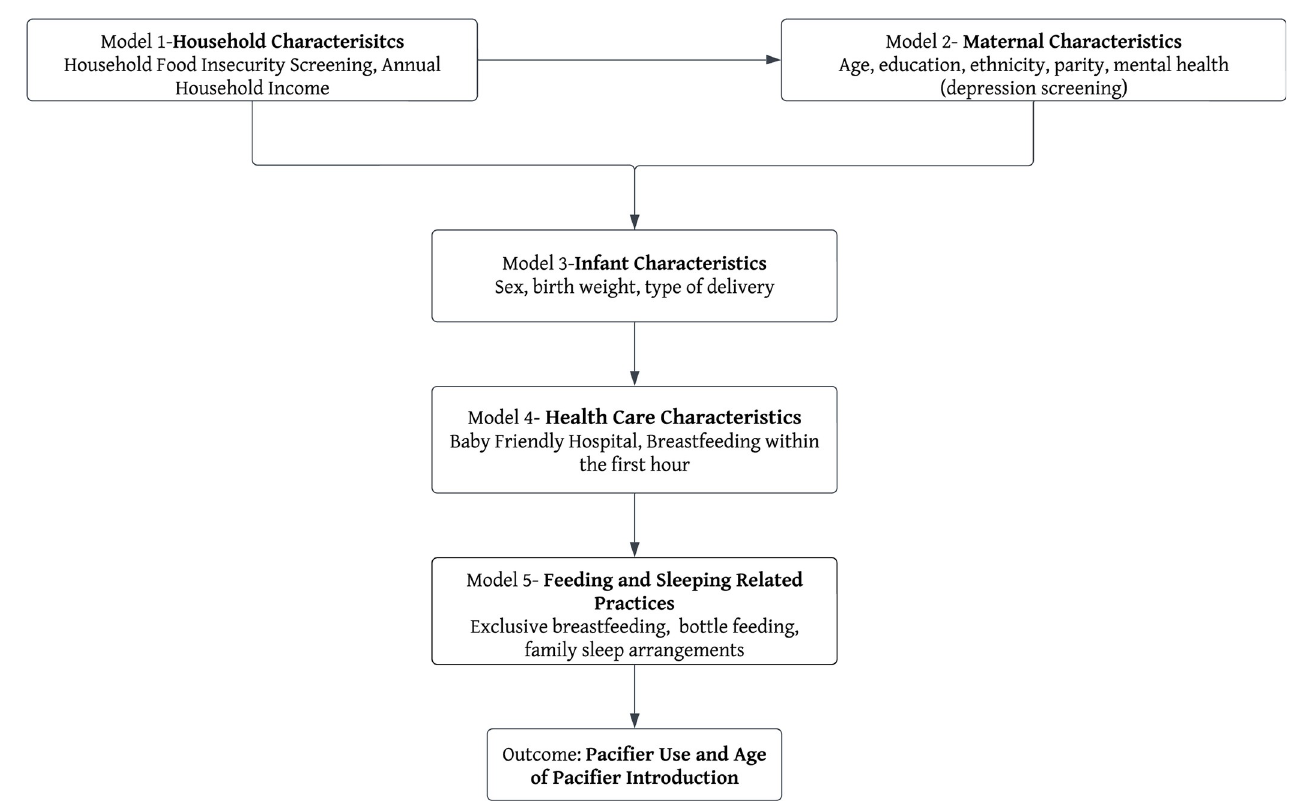
Fig 1. Framework displaying the models used and their proximal relationship to the